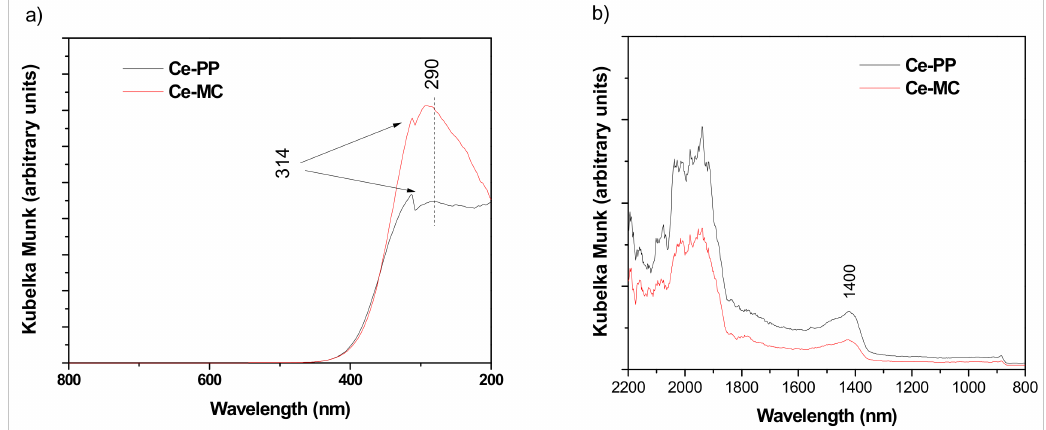
Figure 5. The DRUV-VIS NIR spectra of the calcined Mg 3 Al 0.75 Ce 0.25 oxide samples prepared by co-precipitation and mechanochemical methods in ( a ) UV-Vis and ( b ) NIR